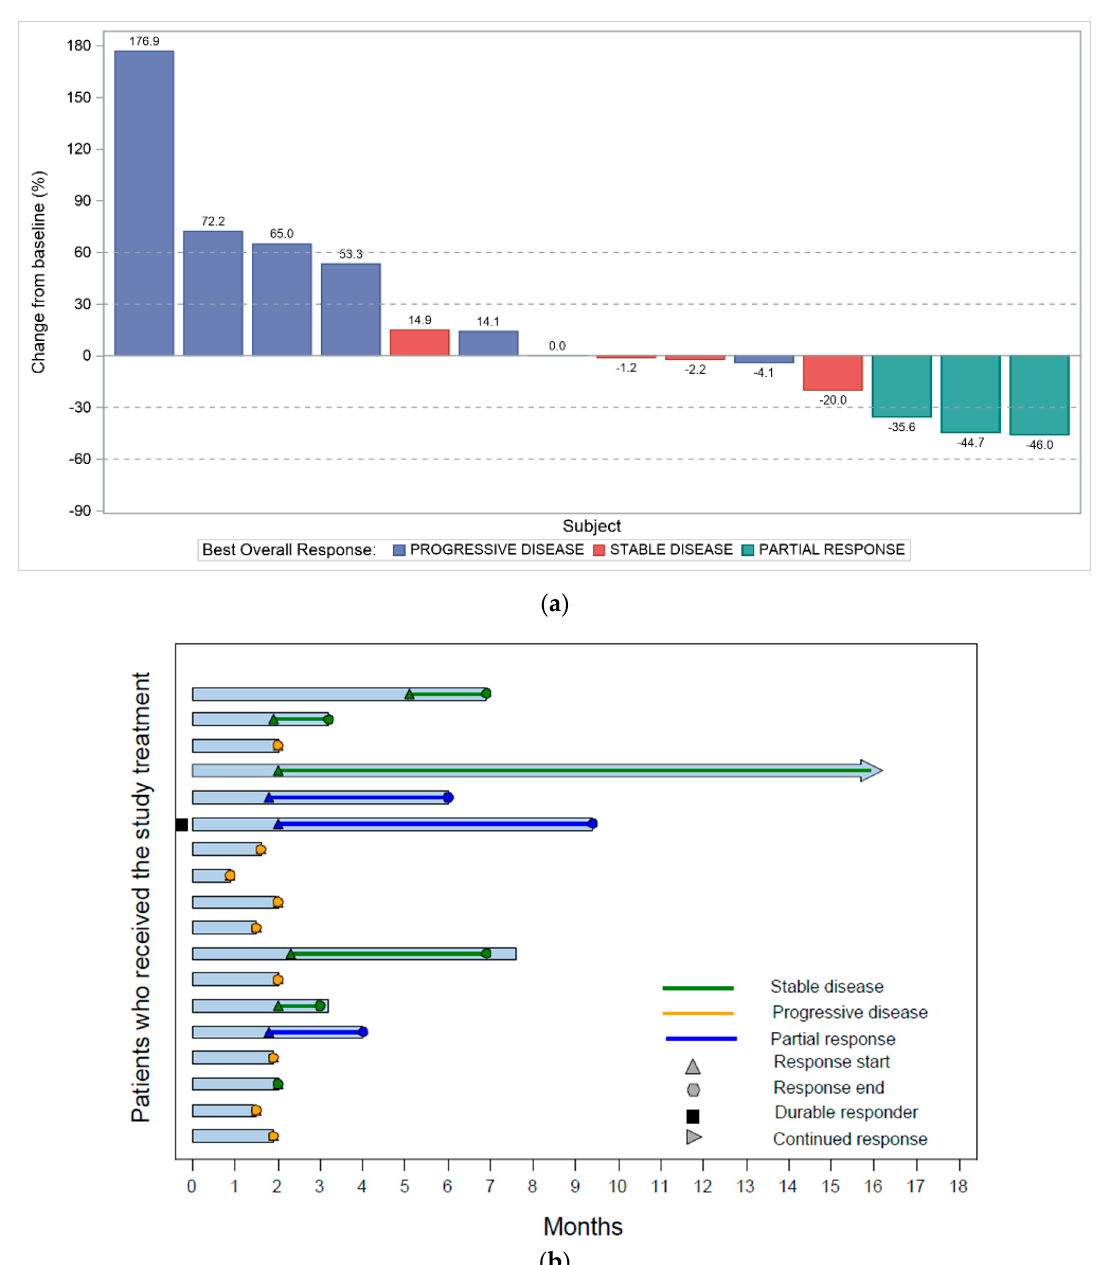
Figure 1. The best overall tumor response per each individual TNBC patient and its duration. ( a ) Waterfall plot. The waterfall plot presents each individual patient’s response to the study treatment based on the change of the sum of the target lesions diameters. The vertical bars are drawn from the baseline, either in the positive or negative direction to depict the change from baseline. Fourteen of the twenty patients analyzed as part of the efficacy population are represented (three patients did not have any tumor response after the beginning of the study treatment as explained in the efficacy section, and the other three patients did not have any change to be represented: two patients progressed with the development of new lesions and another patient had clinical PD). ( b ) Swimmer plot. The swimmer plot shows multiple pieces of each individual patient’s response; the graph includes a bar showing the length of treatment duration and indicators for the start (triangle) and end (circle) of each response episode, classified by a partial response (blue line), stable disease (green line) or progressive disease (dark yellow line), as well as an indicator showing whether the patient is a durable responder (black square) and whether the patient is still on the corresponding response (lying down triangle). In this graphic, the twenty-one TNBC patients are considered as the intention-to-treat population, however, the three patients without tumor response assessment after the beginning of the study treatment are not included.